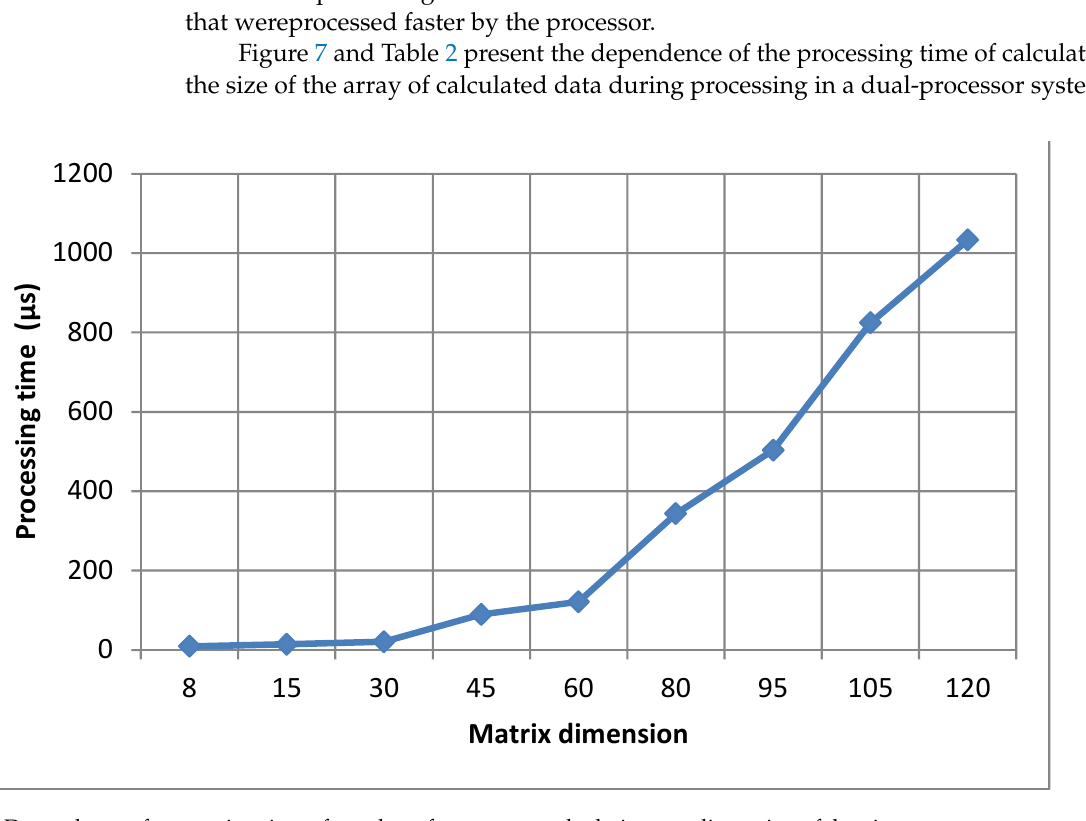
Figure 7. Dependence of processing time of number of processors calculations on dimension of data in two-processor system. Table 2. Dependence of processing time on the size of the array of calculated data Matrix